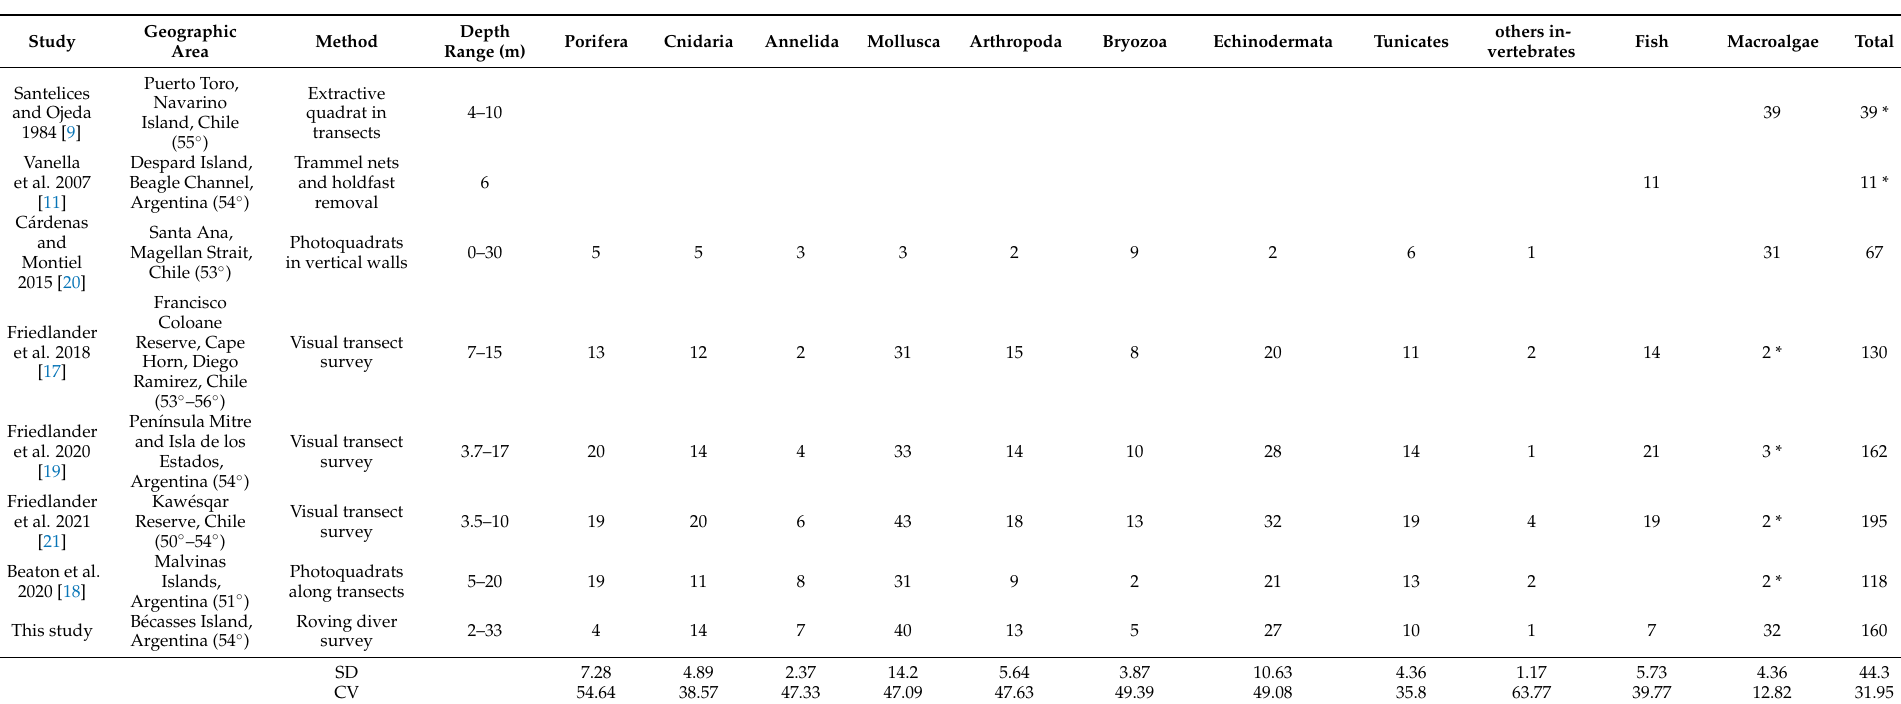
Table 2. List of studies in the nearby areas with information of the type of methodology, the depth range, and the number of taxa found by taxonomic groups. SD = standard deviation and CV = coefficient of